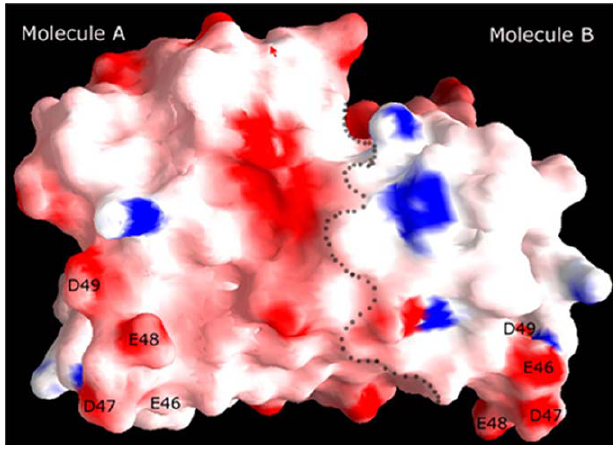
Figure 3. The Electrostatic Surface Potential of GrlR Dimer The surface-exposed (EDED) residues are labeled. It shows a strong negatively charged (red) patch from both EDED motifs of the monomers. The dotted line indicates the dimer interface. Blue represents a positive charge. This figure was prepared using GRASP [20]. Figure 5. General Secretion Profile of EHEC EDL933 Harboring pSA10-